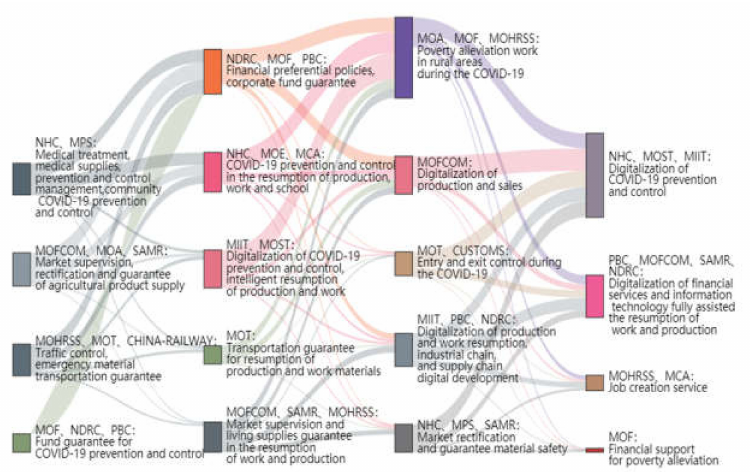
Figure 8. “Agency–topic” relationship evolution Sankey